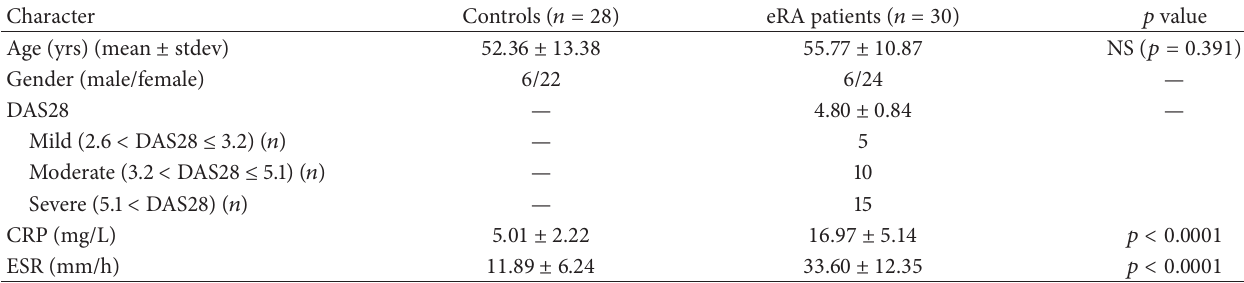
Table 1: Clinical characteristics of the study subjects.